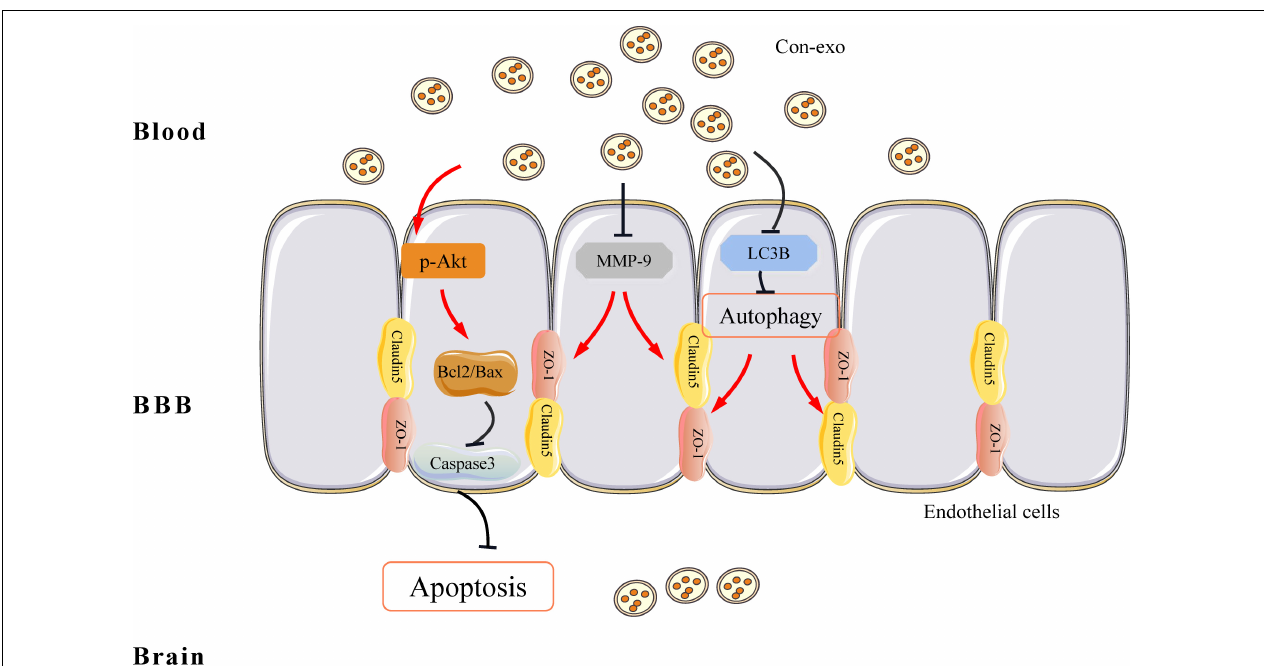
FIGURE 6 | Graphical illustrating of serum exosomes protecting the BBB after ischemia/reperfusion injury. From the antiapoptosis view, serum exosomes enhance the ratio of Bcl2 to Bax and prevent caspase-3 activation via increasing Akt phosphorylation. On top of that, in tight junction’s perspective, serum exosomes reverse the abundance of ZO-1 and claudin-5, while prevent MMP-9 activation. On the other hand, serum exosomes inhibit LC3B-mediated autophagy, which also contributes to the preservation of ZO-1 and claudin-5 under ischemia/reperfusion injury. BBB, blood–brain barrier; Bcl2, B-cell leukemia/lymphoma 2; Bax, Bcl2-associated X protein; Akt, protein kinase B; ZO-1, zonula occludens 1; MMP-9, matrix metalloproteinase-9; LC3B, microtubule-associated protein 1 light chain 3B